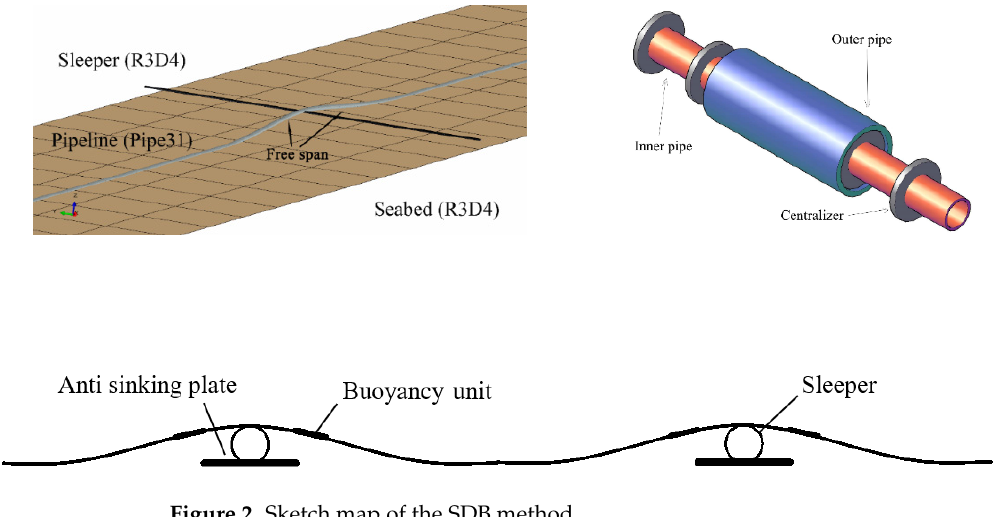
Figure 2. Sketch map of the SDB method.